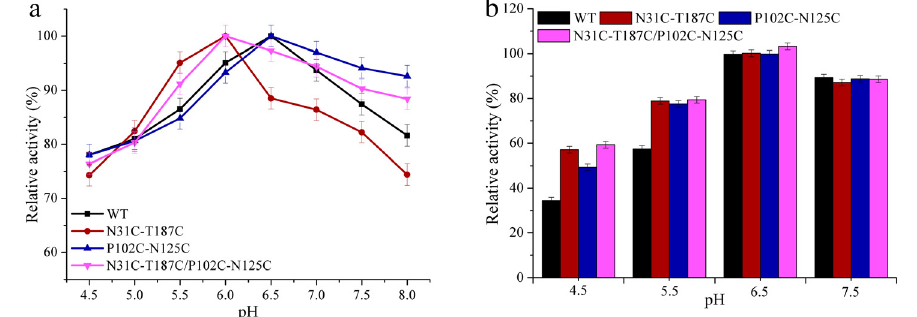
Fig 2. The optimal pH (a) and pH stability (b) of wild-type BglTM and the mutants.